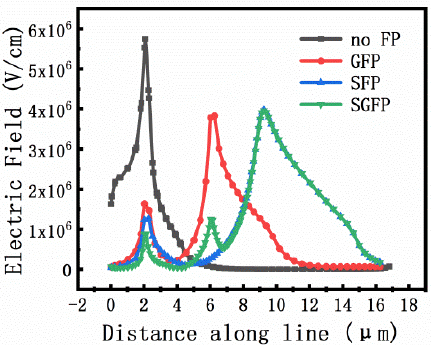
Figure 3. Simulated electric field strength of different field plate types.